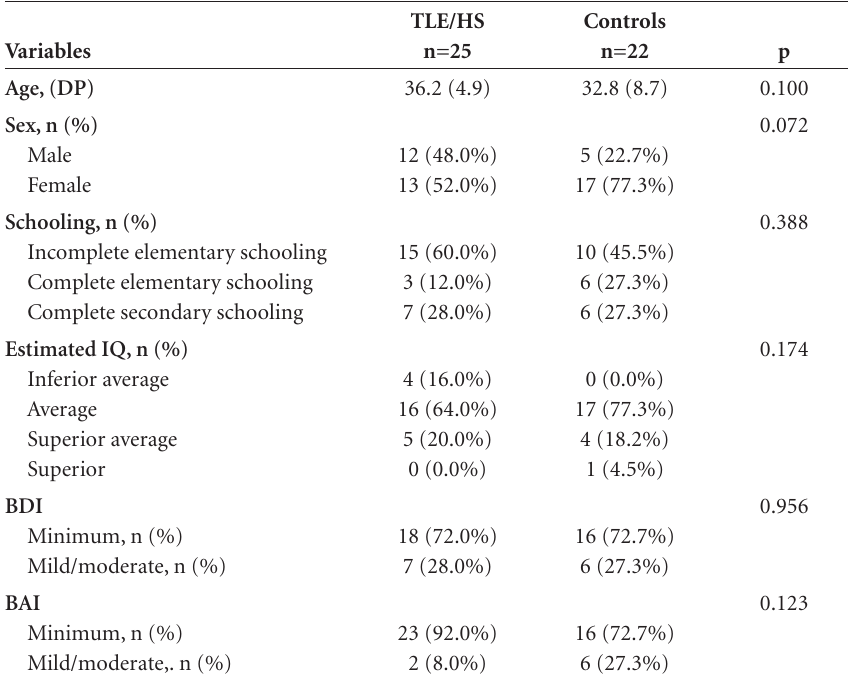
Table 1. Demographic, IQ, and psychiatric fi ndings.